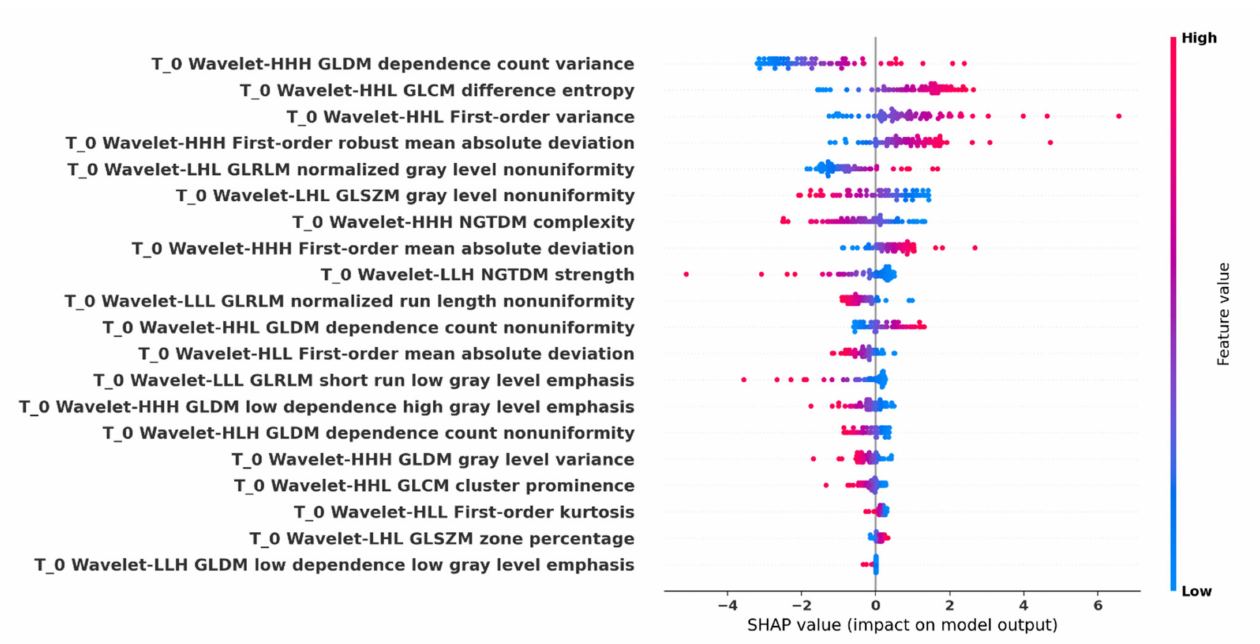
Figure 10. Shapley additive explanations (SHAP) summary plot. All important radiomics feature values are displayed as dots using a pseudocoloring (blue to red), low or zero contributors are near a SHAP value of zero, a long distance from zero denotes a higher influence of a specific feature in the prediction performance, where decreased or increased values favored the negative (IDH-mutant) or positive (IDH-wildtype) classes,